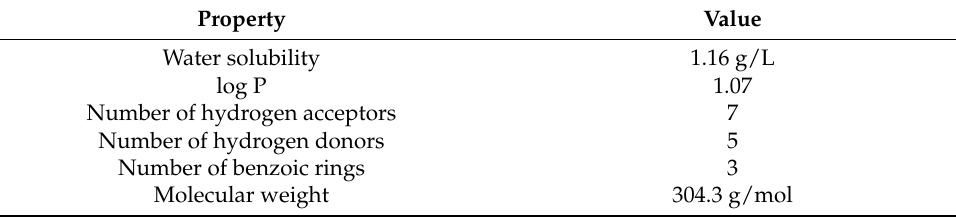
Figure 1. The spatial structure of the taxifolin molecule [38]. Table 1. Physical and chemical properties of taxifolin